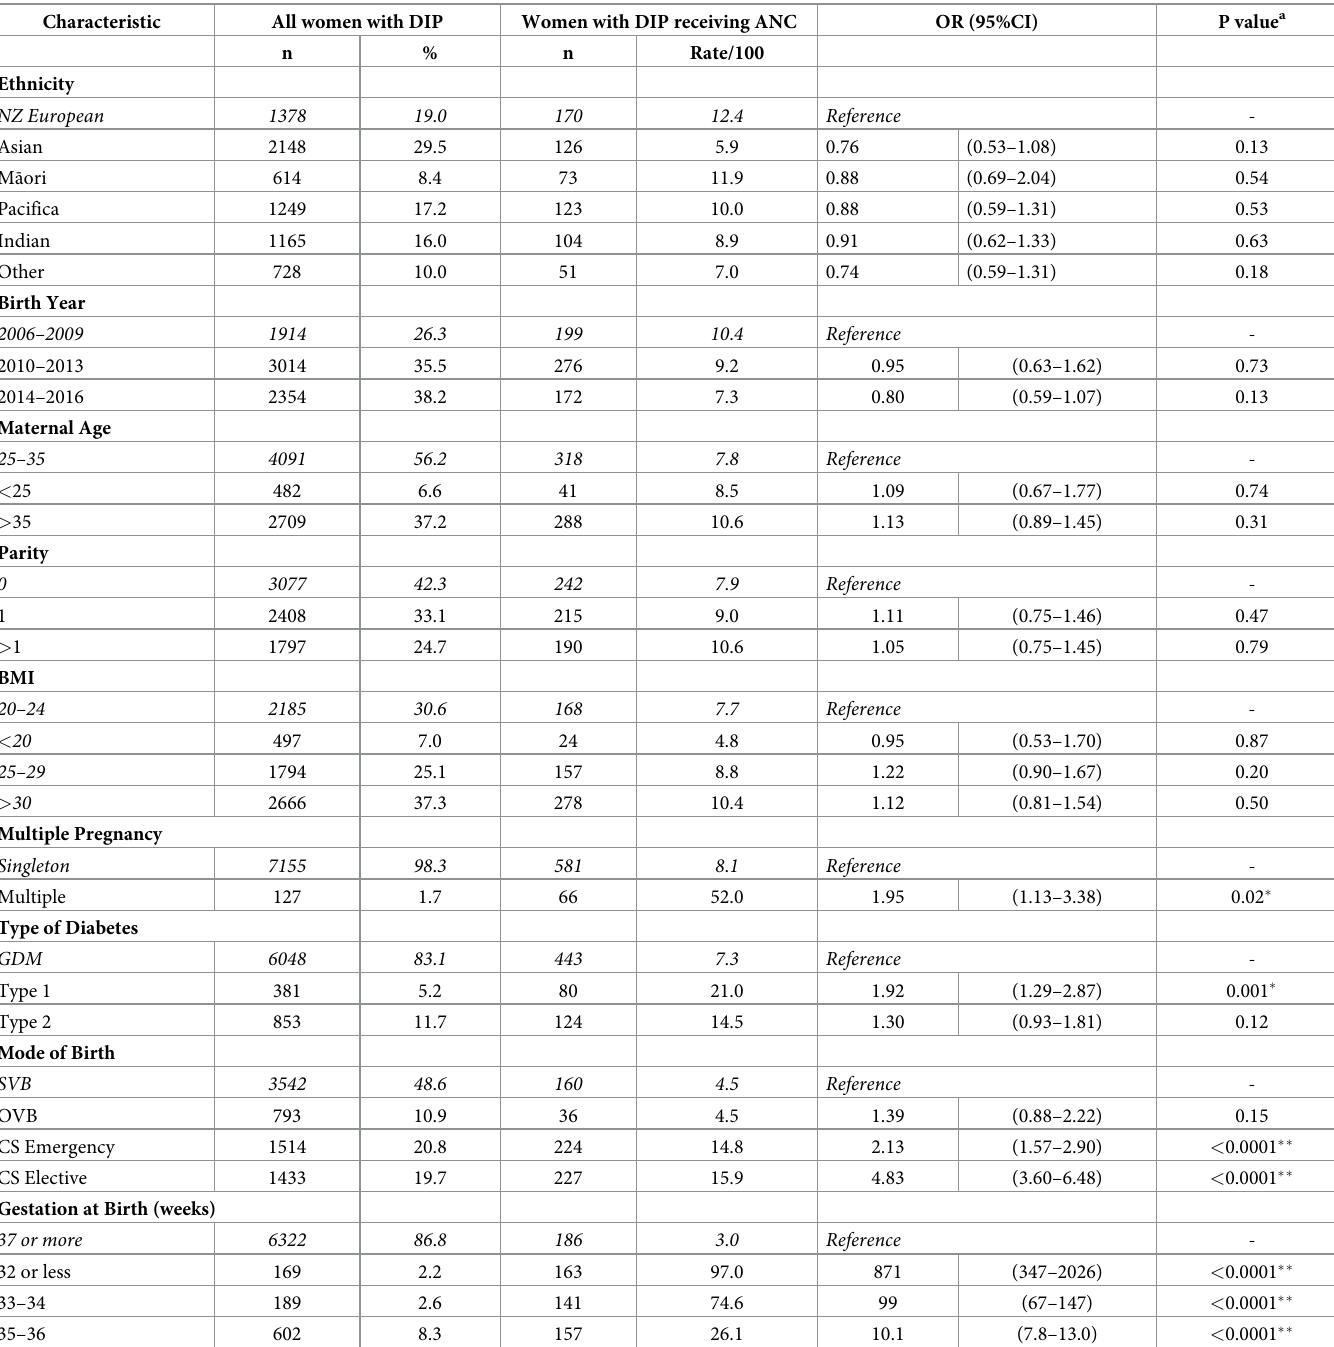
Table 1. Receipt of ANC in women with DIP and different demographic and obstetric characteristics.